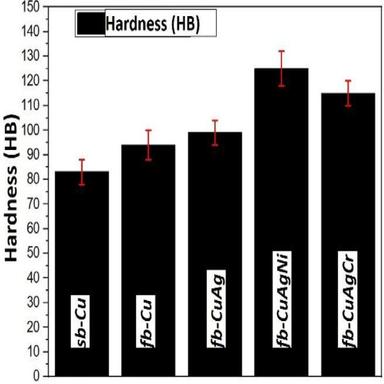
The hardness values of bulk materials.